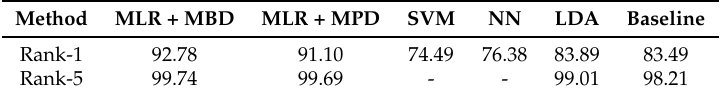
Table 4. Method performance for all beat classes on MLV.